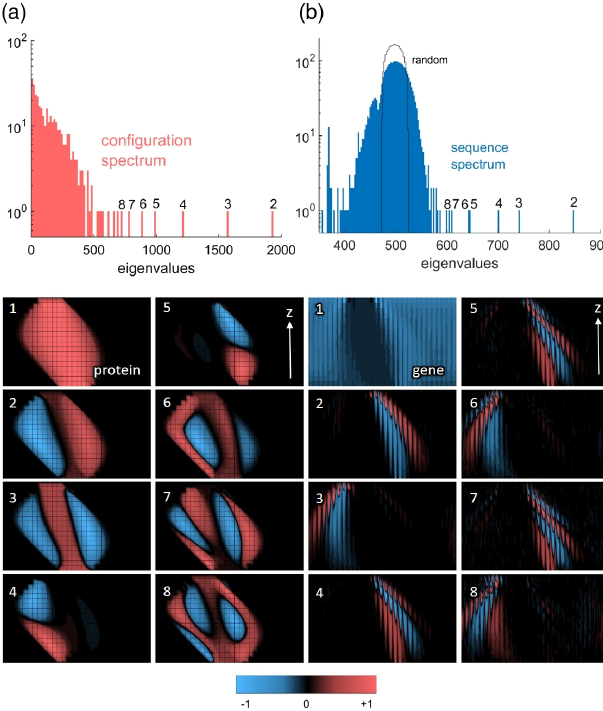
FIG. 6. Correspondence of modes in sequence and configura- tion spaces. We produce the spectra by singular value decom- position of the 10 6 solutions of problem S . The corresponding spectra for the T case are shown in Fig. 7. (a) Top: The spectrum in configuration space exhibits about 8 – 10 eigenvalues outside the continuum (large first eigenvalue not shown). Bottom: The corresponding eigenvectors describe the basic modes of the fluid channel, such as side-to-side shift (second) or expansion (third). (B) Top: The spectrum of the solutions in sequence space is similar to that of random sequences (black line), except for about 8 – 9 high eigenvalues that are outside the continuous spectrum. Bottom: The first eight eigenvectors exhibit patterns of alternating þ = − stripes — whichweterm correlationripples — aroundthefluid channel region. Seeing these ripples through the random evolu- tionary noise requires at least 10 5 independent solutions [39].